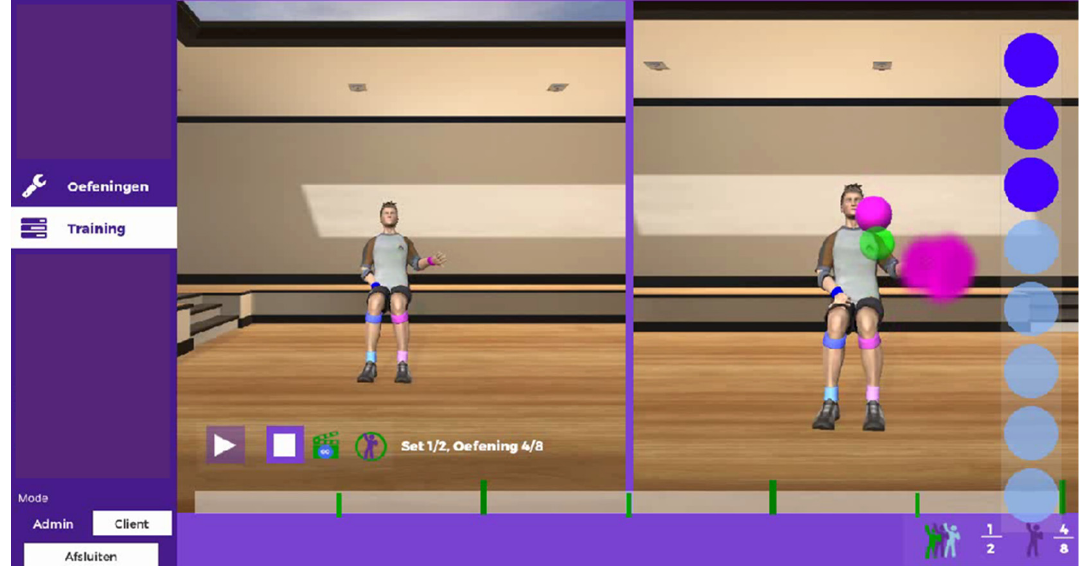
Figure 1. Patient interface during performance of the exercise “drinking from a cup”. The avatar on the left represents the therapist (i.e., recorded movement) while the avatar on the right represents the patient. The green dot is the stability point for restriction of compensational movement. The pink dots are the targets for the right hand.